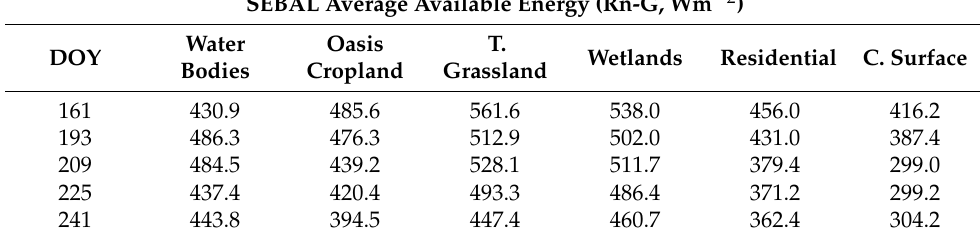
Figure 6. SEBAL-derived available energy distribution across the Yanqi land use types during the understudied period. On each boxplot, the central mark represents the median, while the upper and lower edge determines the first and the third quartiles, respectively. Lately, the whiskers extend to a minimum up to a maximum value. Table 4. Statistics on average of available energy derived from the variance between net radiation (Rn) and ground heat flux parameters(G) over Yanqi land use categories.